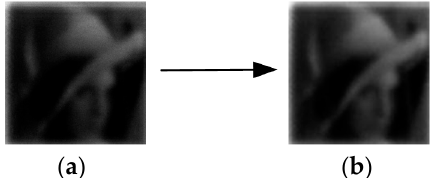
Figure 6. Denoising effect of photon counting image without any enhancement such as contrast and brightness: ( a ) photon counting image; ( b ) denoised image using block-matching 3D filter.